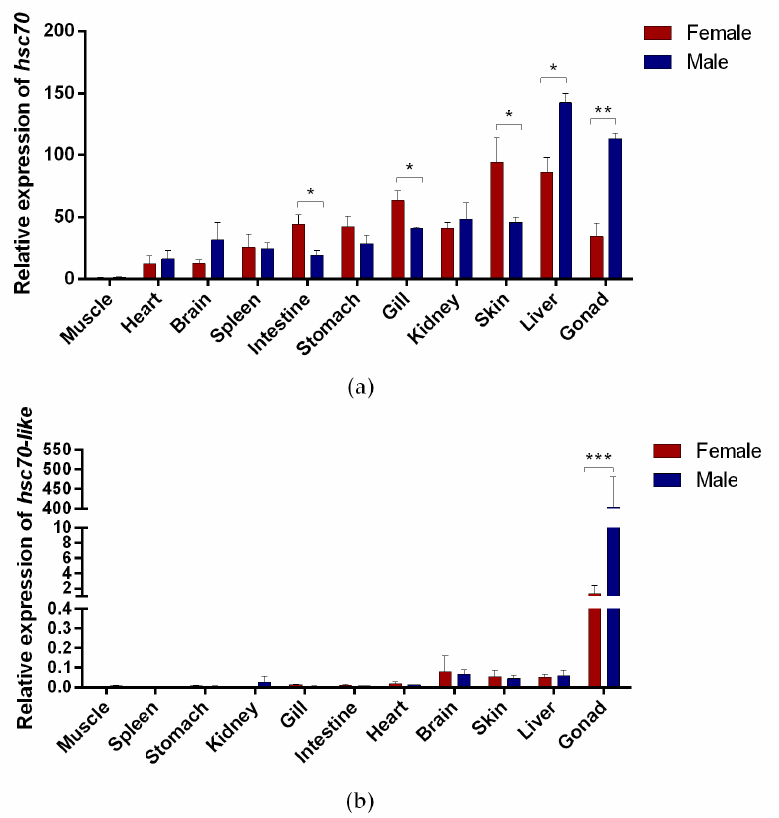
Figure 4. Expression of hsc70 and hsc70-like genes in adult C. semilaevis tissues. ( a , b ) Detection of hsc70 ( a ) and hsc70-like ( b ) expression in C. semilaevis tissues by RT—qPCR. Means ± SEM from three independent individuals ( n = 3) were shown. β -actin was used as the reference gene. Asterisks indicated statistically significant differences (* p <0.05; ** p < 0.01; *** p < 0.001).